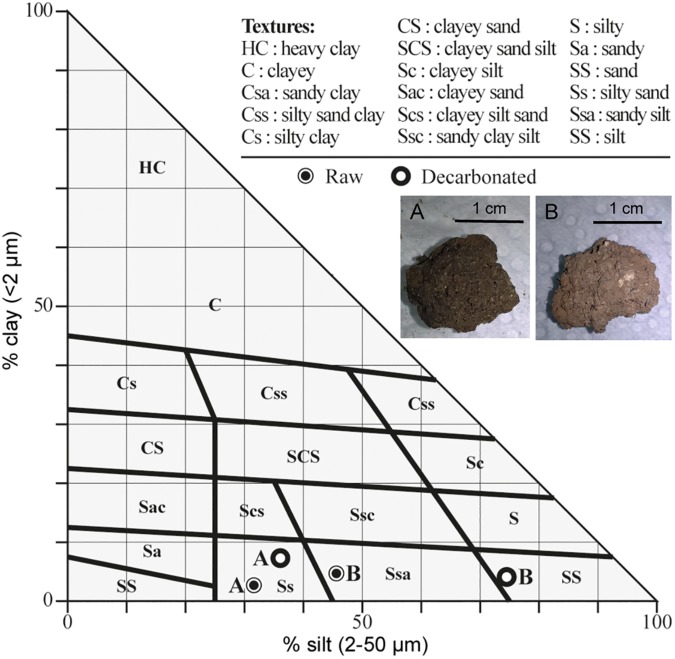
GEPPA soil texture triangle diagram.Grain size distribution data are plotted for raw and decarbonated soil A and soil B samples. Inserts show pictures of soils A and B.